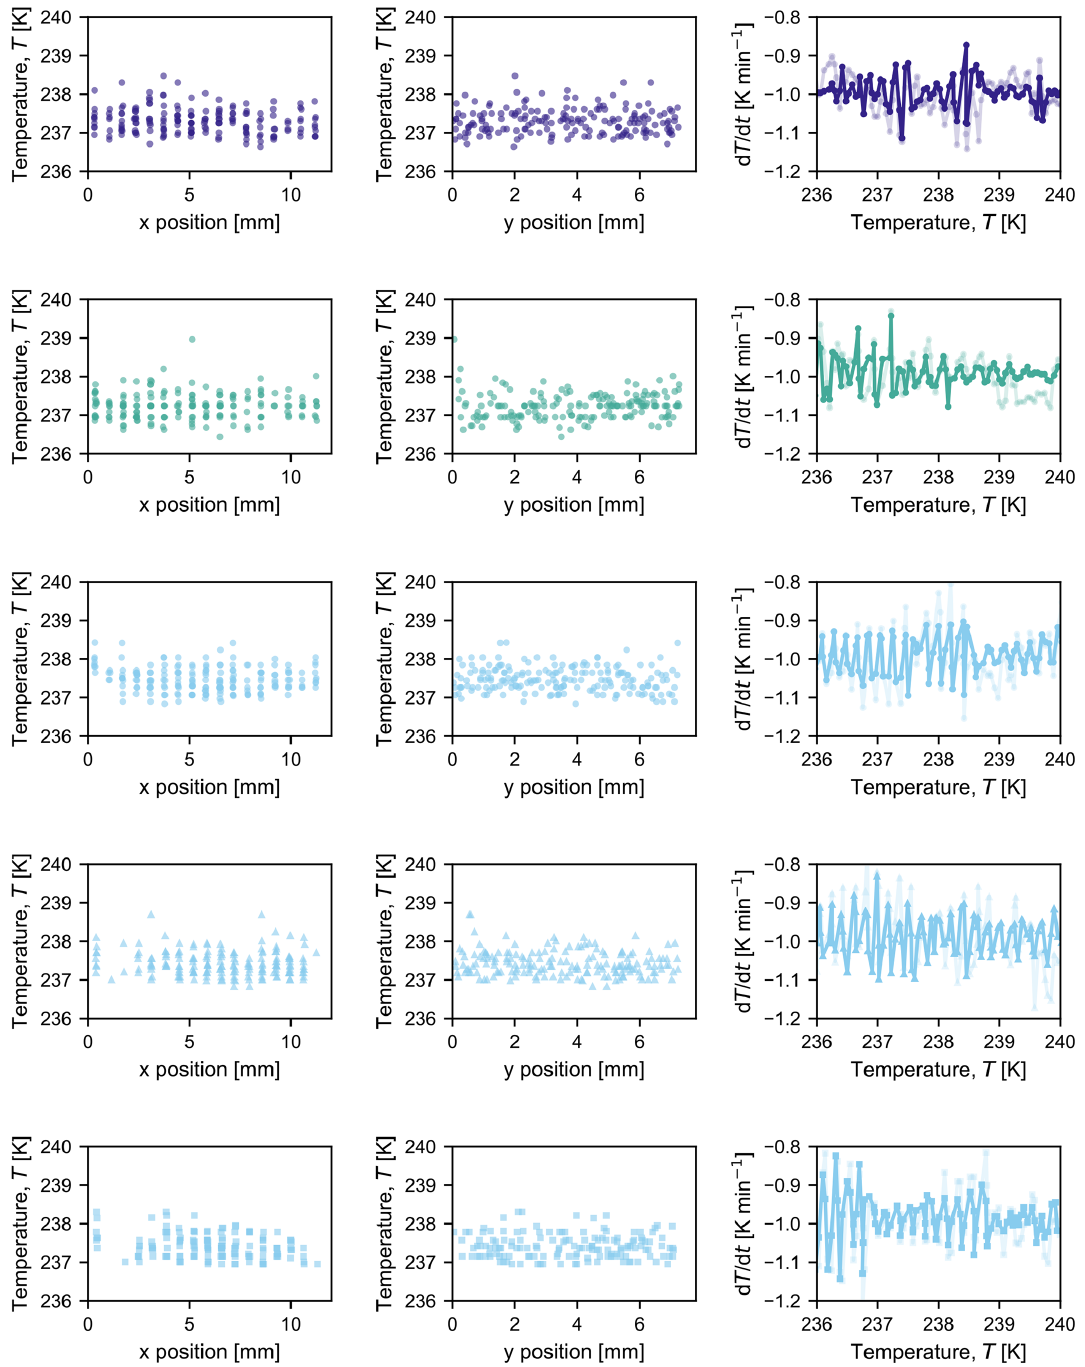
Figure B1. Compilation of observed freezing temperatures at each x and y position to illustrate that there is no discernable spatial bias in freezing temperature for each experiment conducted with pure water in Fig. 3 (from top to bottom: water day 1, water day 2, and water day 3a, b, and c). The third graph in each row shows the measured cooling rate at each temperature at which a picture was taken; the opaque line indicates the cooling rate measured by the thermocouple that was used as input to the control loop, and the semi-opaque line indicates the cooling rate measured by the second thermocouple in the